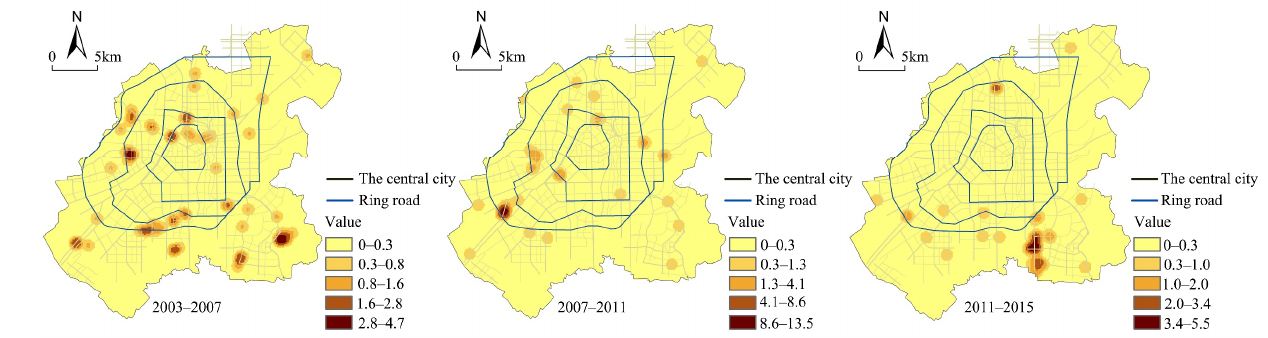
Figure 7. Kernel density map of residential land conversion in different periods.